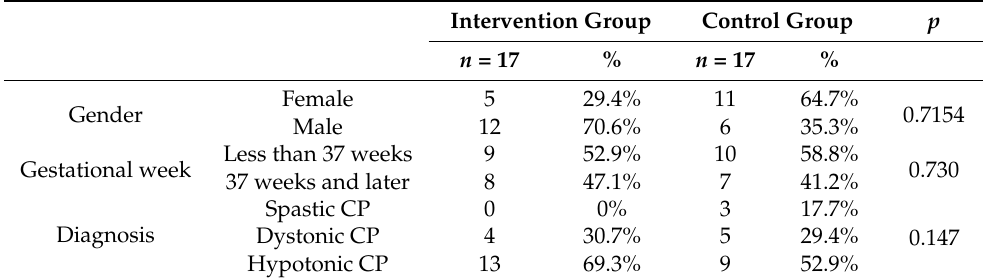
Table 1. Demographic Characteristics of